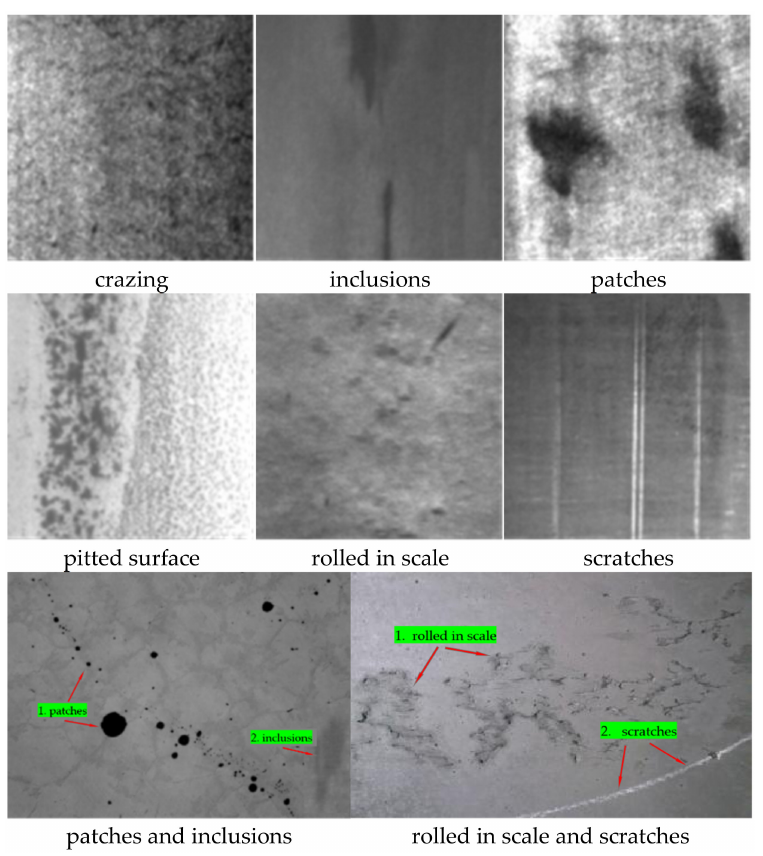
Figure 12. Some of the images from the NEU-DET and Enriched-NEU-DET